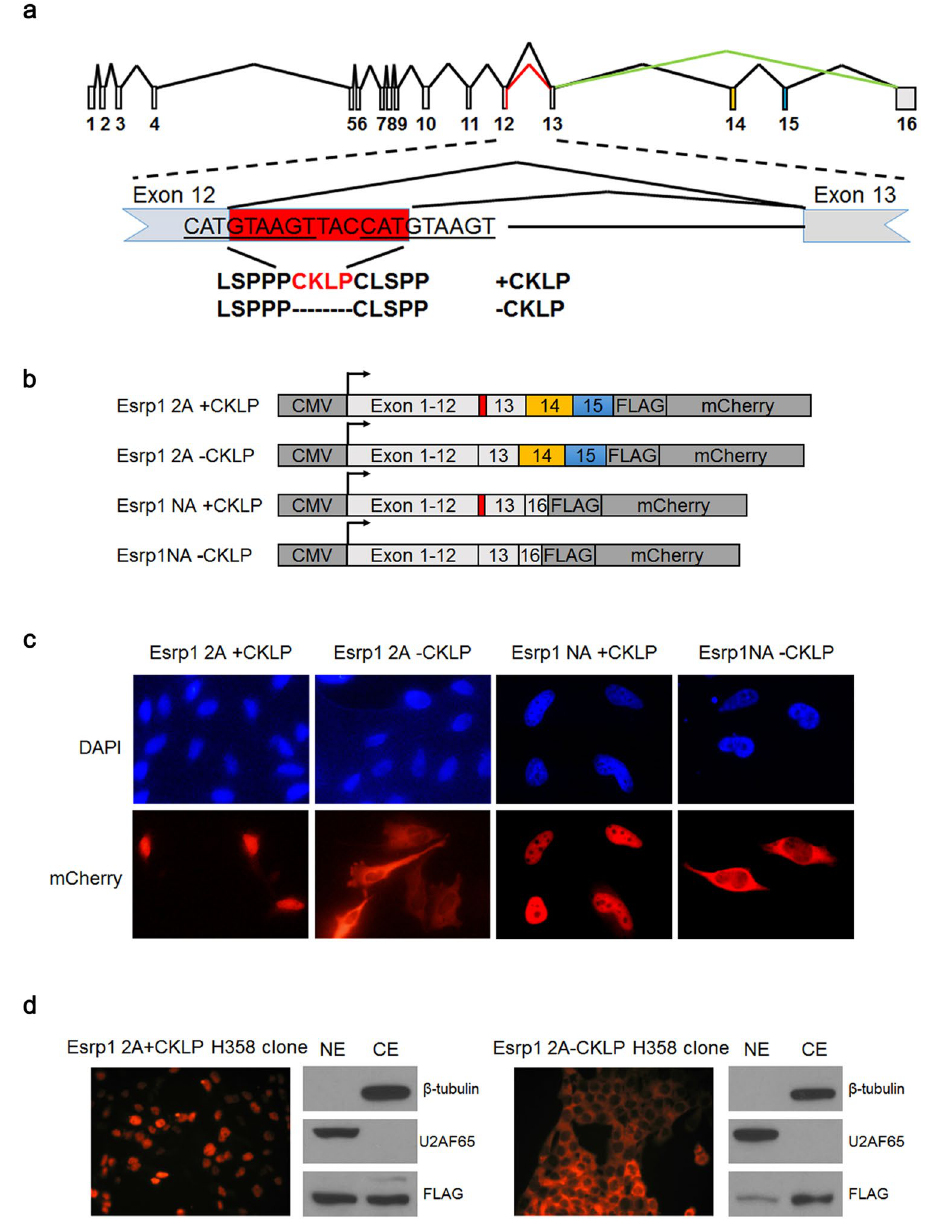
Figure 1. Choice of different alternative 5 ′ splice sites downstream of exon 12 gives rise to Esrp1 isoforms with differential subcellular localization. ( a ) Schematic of the genomic organization and alternative splicing of Esrp1 . Gray boxes indicate constitutive exons. Exons 14 (yellow box) and 15 (blue box) are cassette exons, and exon 12 has an alternative 5 ′ splice site (highlighted in red) with the sequences shown below. ( b ) Schematic of vectors expressing cDNAs for the different full length Esrp1 isoforms as FLAG and mCherry fusion proteins for transfection and microscopy in ( c ). ( c ) Representative images of HeLa cells (20x) transfected with expression vectors of the different Esrp1 isoforms depicted in ( b ), showing that CLKP is required for predominant nuclear localization. mCherry represents the localization of Esrp1 protein, and DAPI represents the nucleus. For each transfection, a qualitative measurement of subcellular localization was quantified for at least 20 cells from at least 3 randomly chosen microscopic fields as described in Methods. The same measurements were done for each transfection in subsequent experiments and these quantifications are summarized in Table 1. ( d ) mCherry fluorescence and Western blots of nuclear and cytoplasmic fractions from human H358 stable clones expressing full length Esrp1 2A + CKLP or 2A − CKLP isoforms confirmed predominant nuclear localization for Esrp1 2A + CKLP protein isoform and cytoplasmic localization for Esrp1 2A − CKLP protein isoform. β -tubulin was used as a cytoplasmic marker, and U2AF65 was used as a nuclear